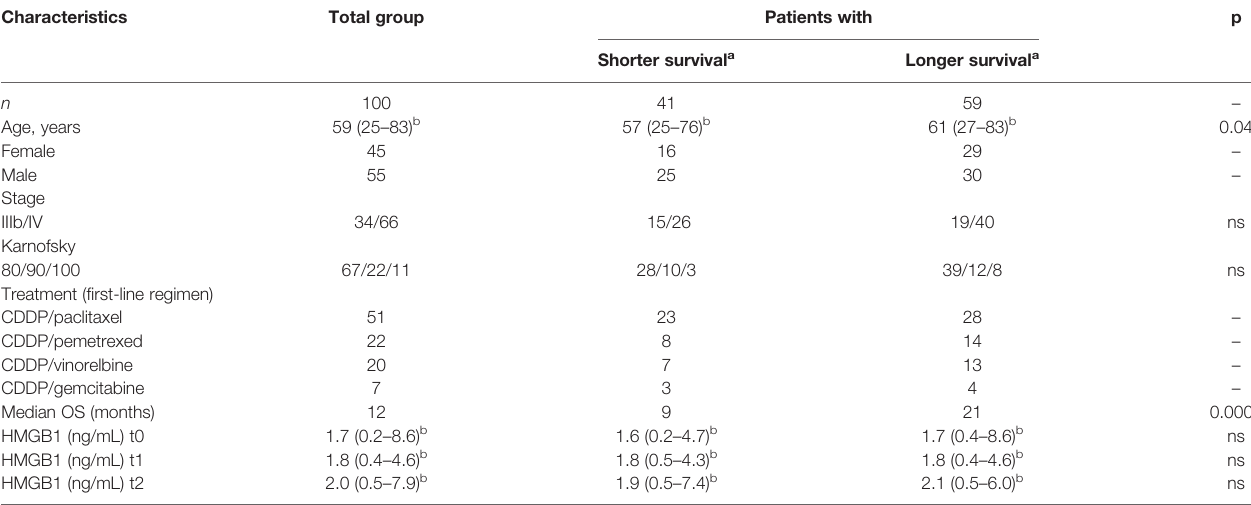
TABLE 1 | Demographic data and clinical characteristics of the cohort of patients with lung adenocarcinoma.